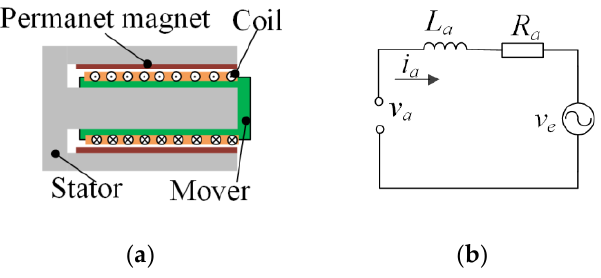
Figure 2. Voice coil motor: ( a ) Structure diagram; ( b ) Circuit equivalent model